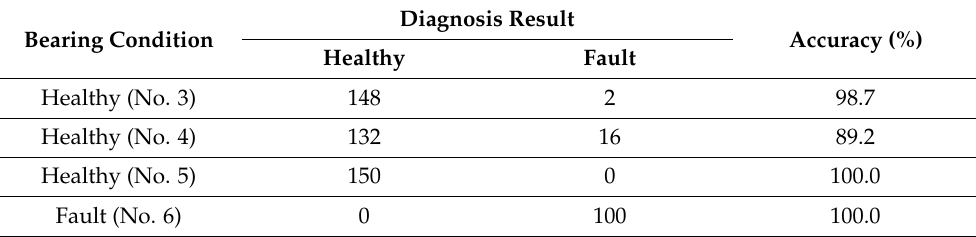
Table 4. Diagnosis result based on Neural Network.